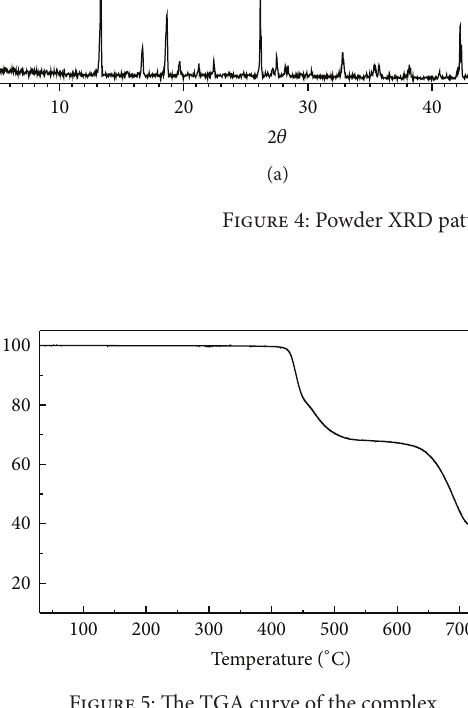
Figure 5: The TGA curve of the complex.